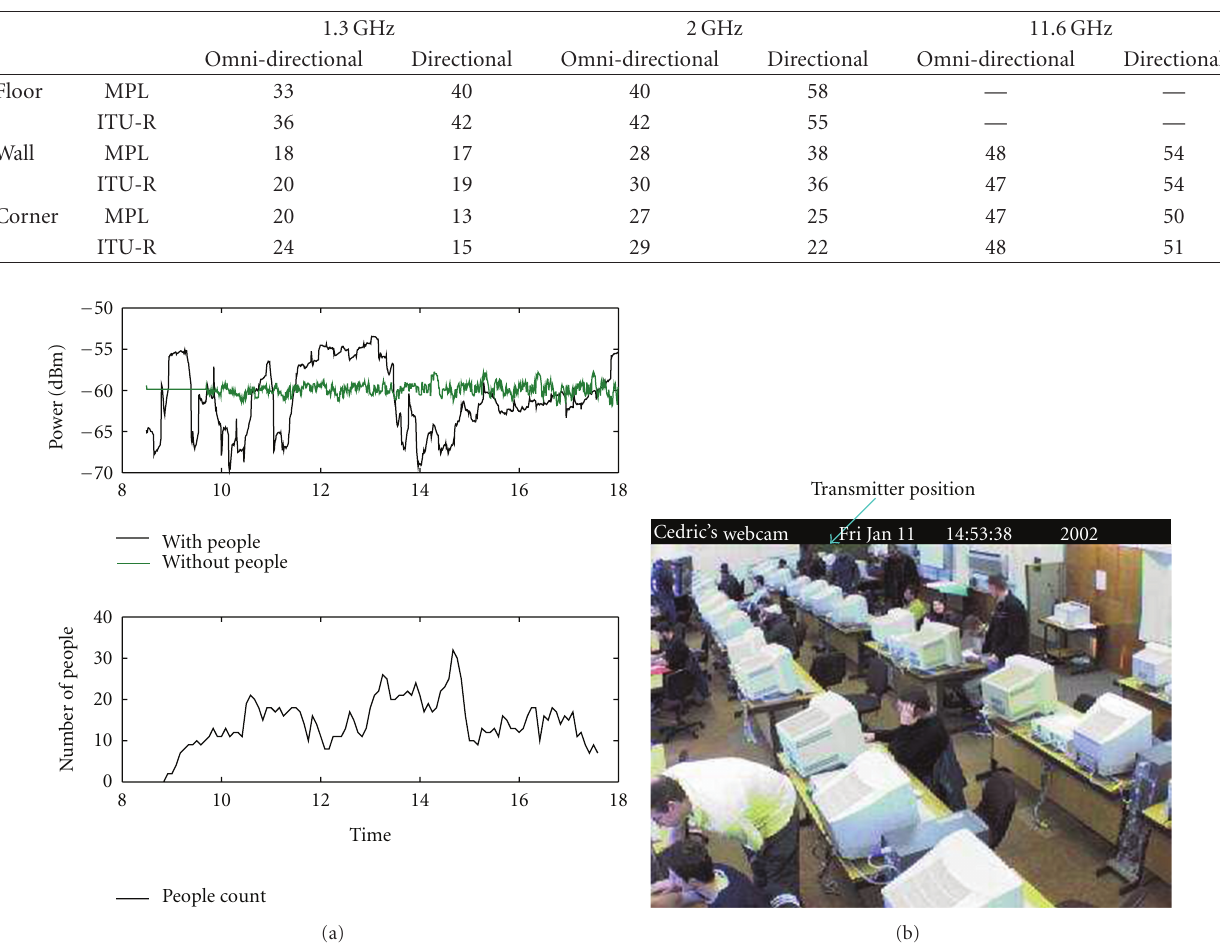
Table 3: Fitted additional loss due to walls and floors (dB).